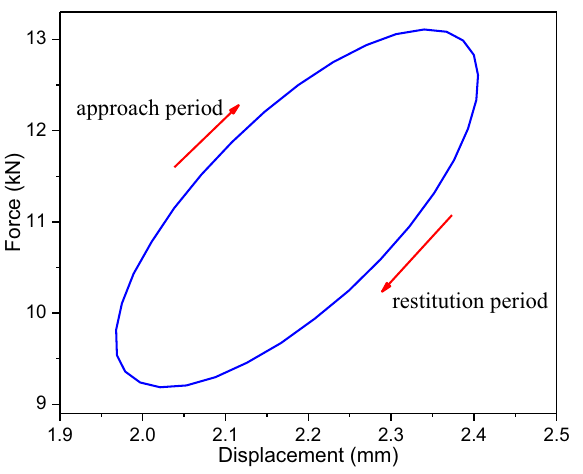
Figure 10. Force–displacement curve.